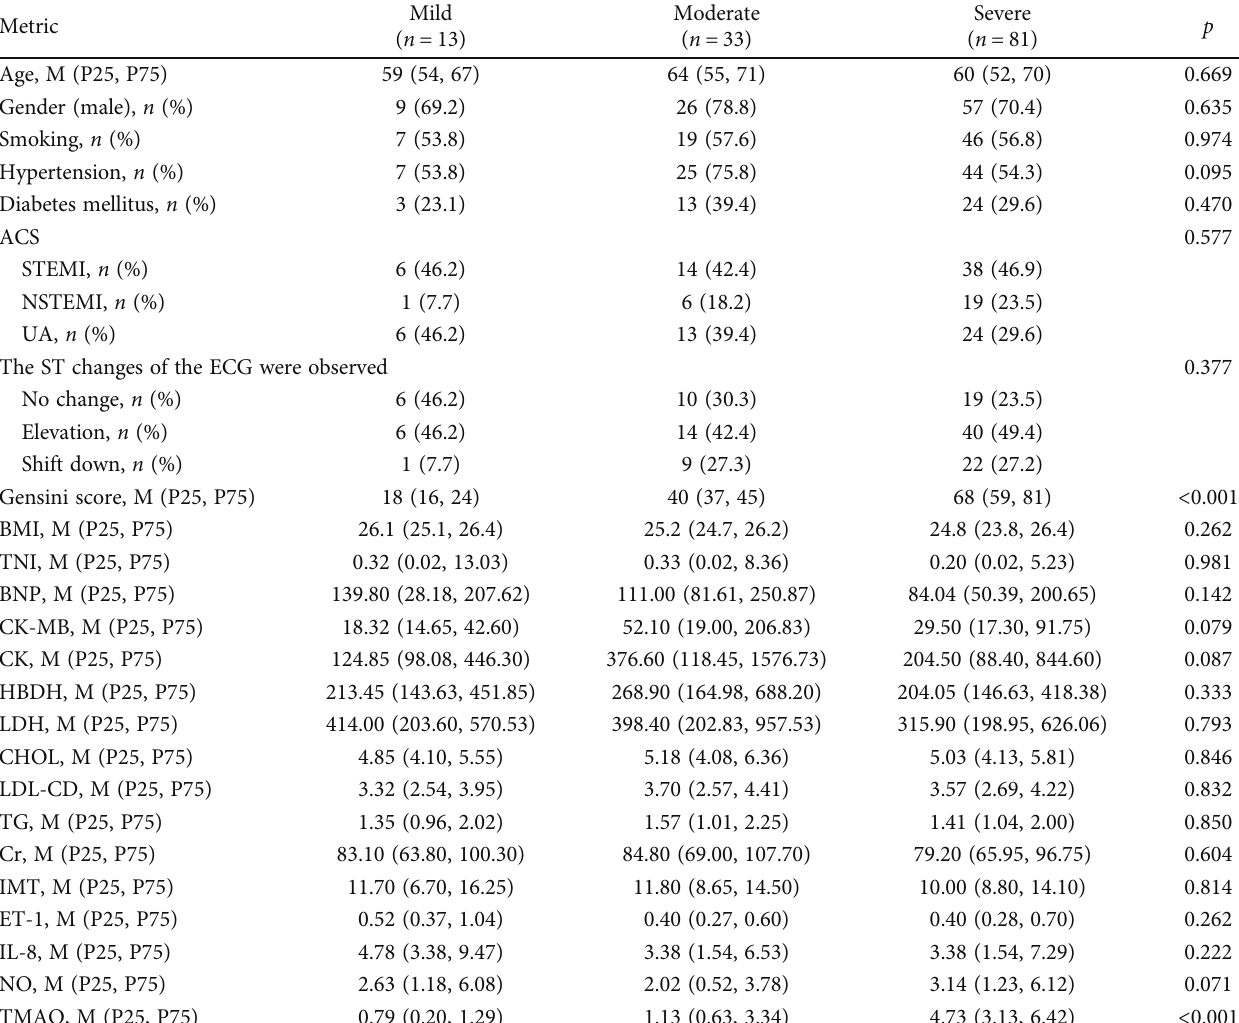
Table 1: Baseline characteristics of